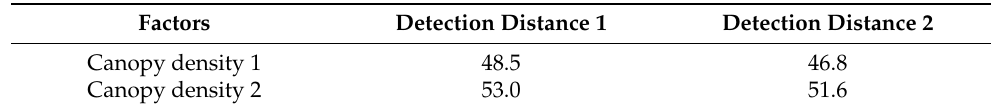
Table 6. Discrimination interaction experiment data 2.